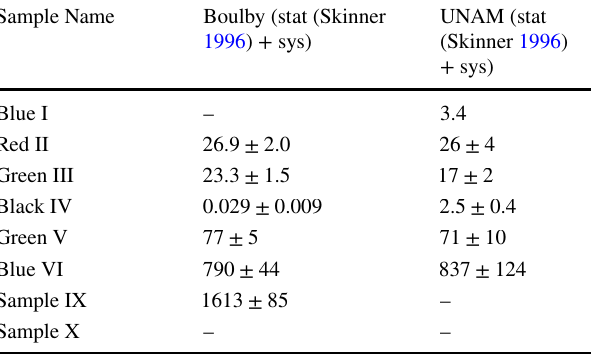
Table 4 Cross calibration of sample’s activities using BEGe detectors at Boulby and IF-UNAM